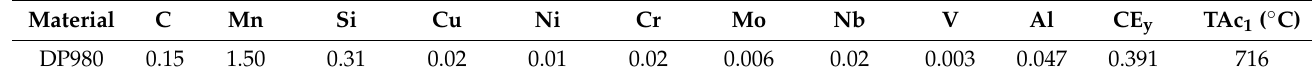
Table 1. Chemical composition of DP980 steel sheet (wt.%).